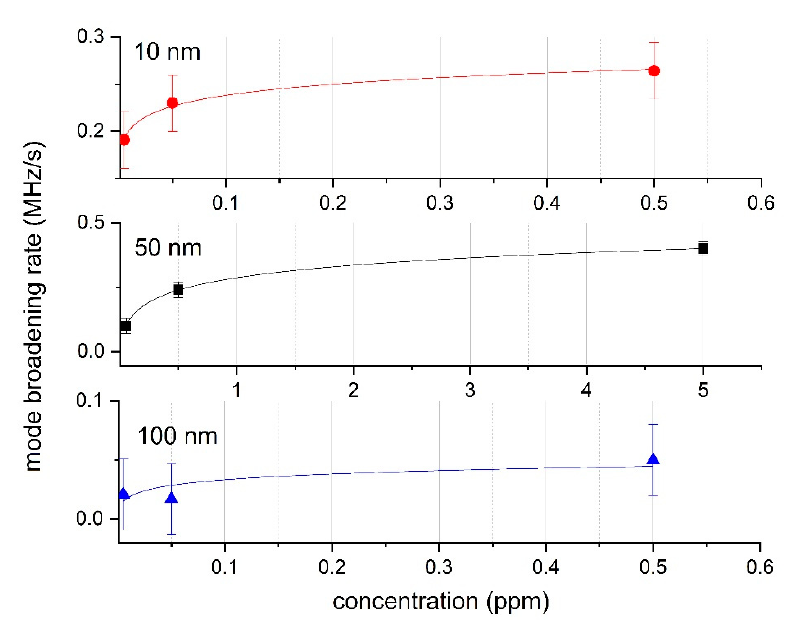
Figure 5. A calibration graph of the dependence of the mode broadening rate on the concentration of nanoparticles in a colloidal solution for particles with different sizes: 10 nm (red), 50 nm (black), 100 nm (blue).